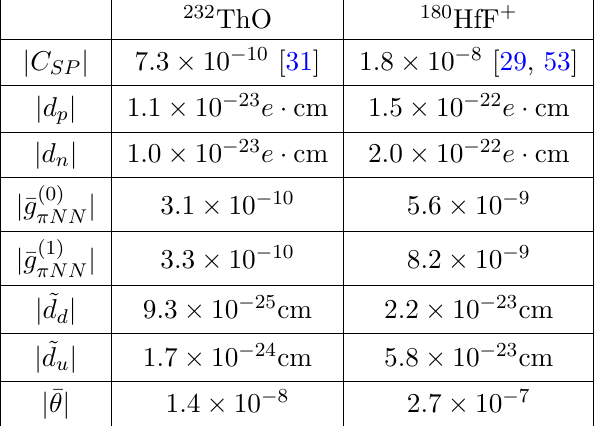
Table 1 . The results of numerical computations of the coe(cid:14)cients (cid:21) 1 ; : : : ; (cid:21) 7 in eqs. (4.3), (4.8), (4.10) and (4.13). 232 ThO 180 HfF +